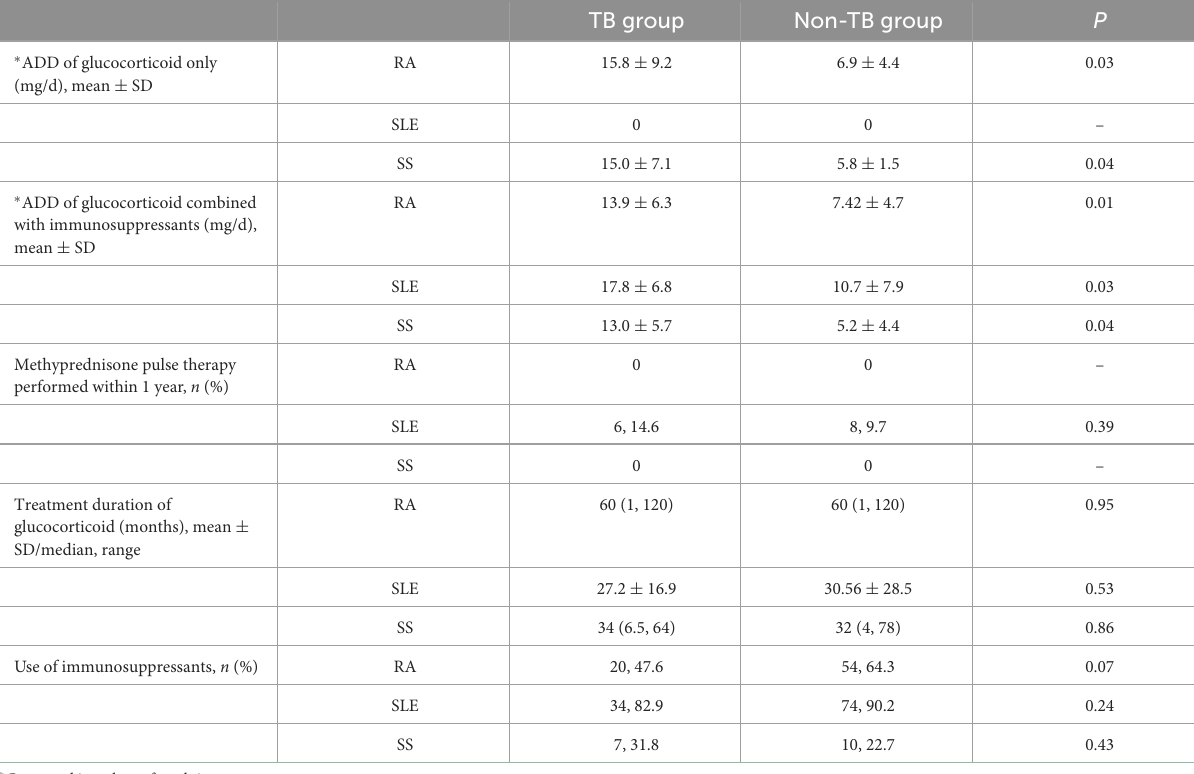
TABLE 5 Medication administration in the TB and non-TB groups.